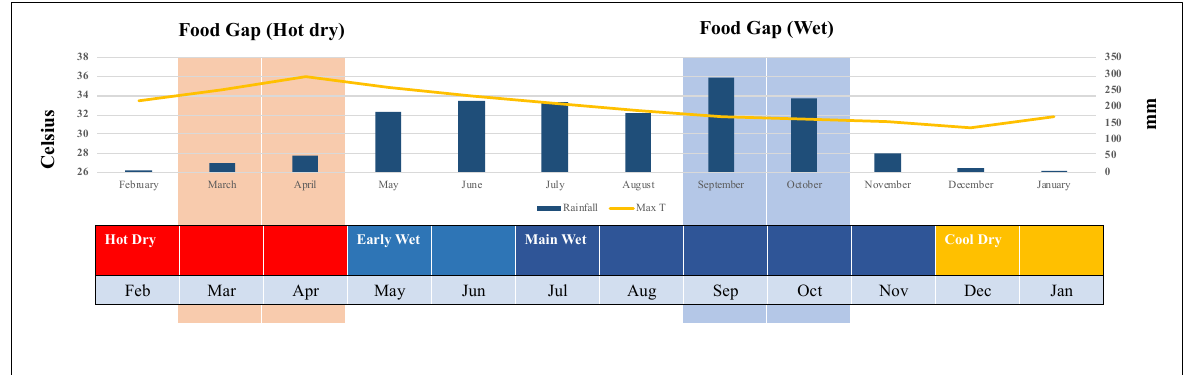
a Figure presents rainfall and temperature data from Siem Reap Province, 1998–2010. Image Author: Stuart Brown, World Vegetable